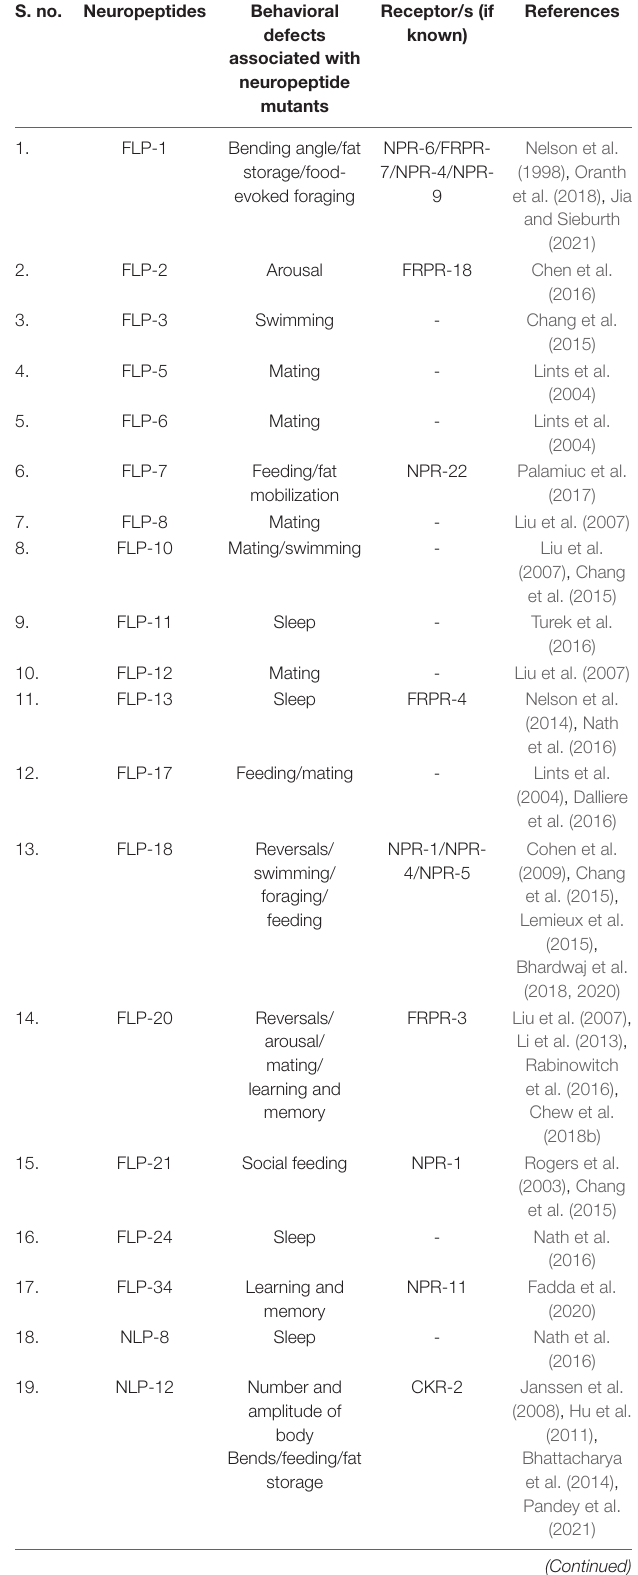
TABLE 1 | List of neuropeptides discussed in this